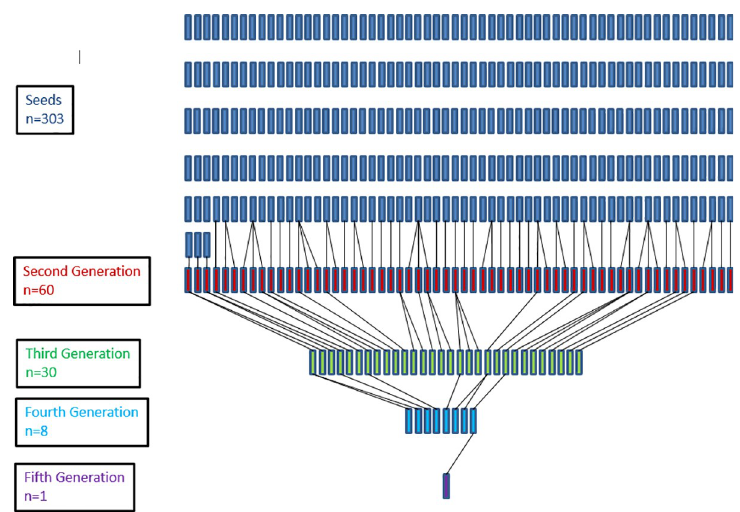
Fig 1. Recruitment networks from RDS sample of mothers in Washington, DC